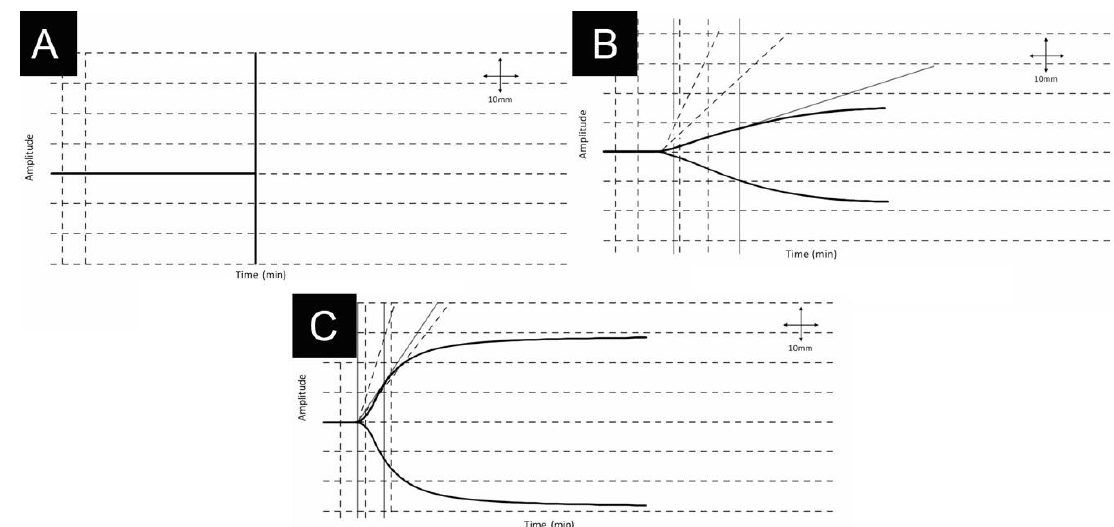
Figure 2. 35-year-old woman presenting with a cardiac arrest due to an amniotic fluid embolism during delivery. Patient required cardiopulmonary resuscitation and developed immediate disseminated intravascular coagulation, respiratory and renal failure which required ventilation and eventual dialysis. The fetus was successfully delivered by immediate cesarean section and the patient completely recovered. First thromboelastography tracing reveals no clot formation ( A ). Improvement over 2 ( B ) and 8 ( C ) hours were achieved by following thromboelastography-guided massive transfusion and use of HAT. Physiologic thromboelastography tracing is also depicted ( C ) Adapted from [29] permission from J. Extra Corpor Technol., 2016.